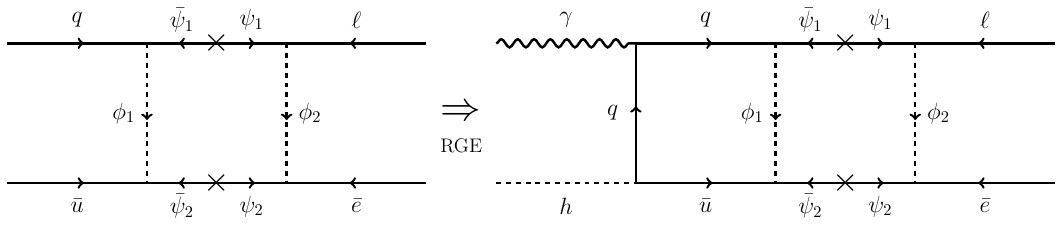
Figure 9 . Feynman diagrams for an EDM arising at two loops from a one-loop QULE operator. Similar diagrams exist that generate the operator ( q (cid:22) e )